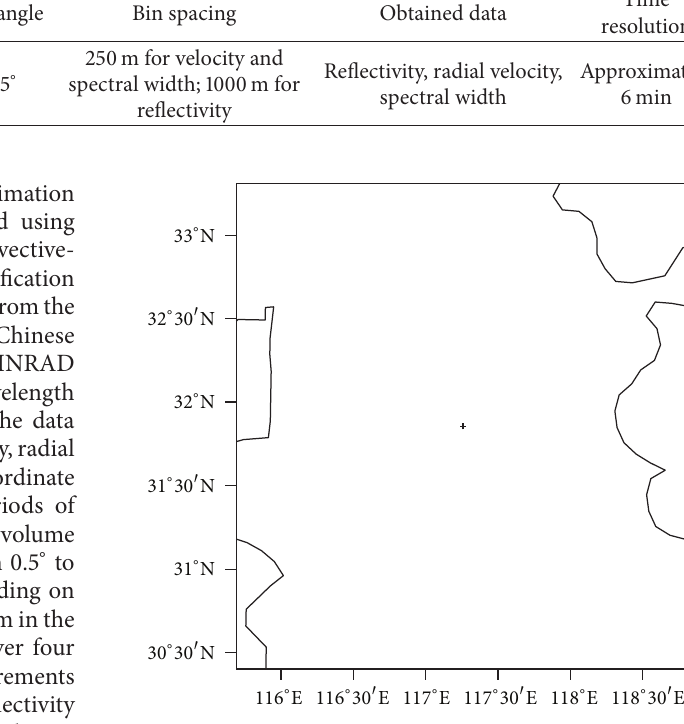
Figure 2: Study domain (the “+” represents the Hefei radar loca- tion). Table 2: Error analysis of the June–August, 2010, data.